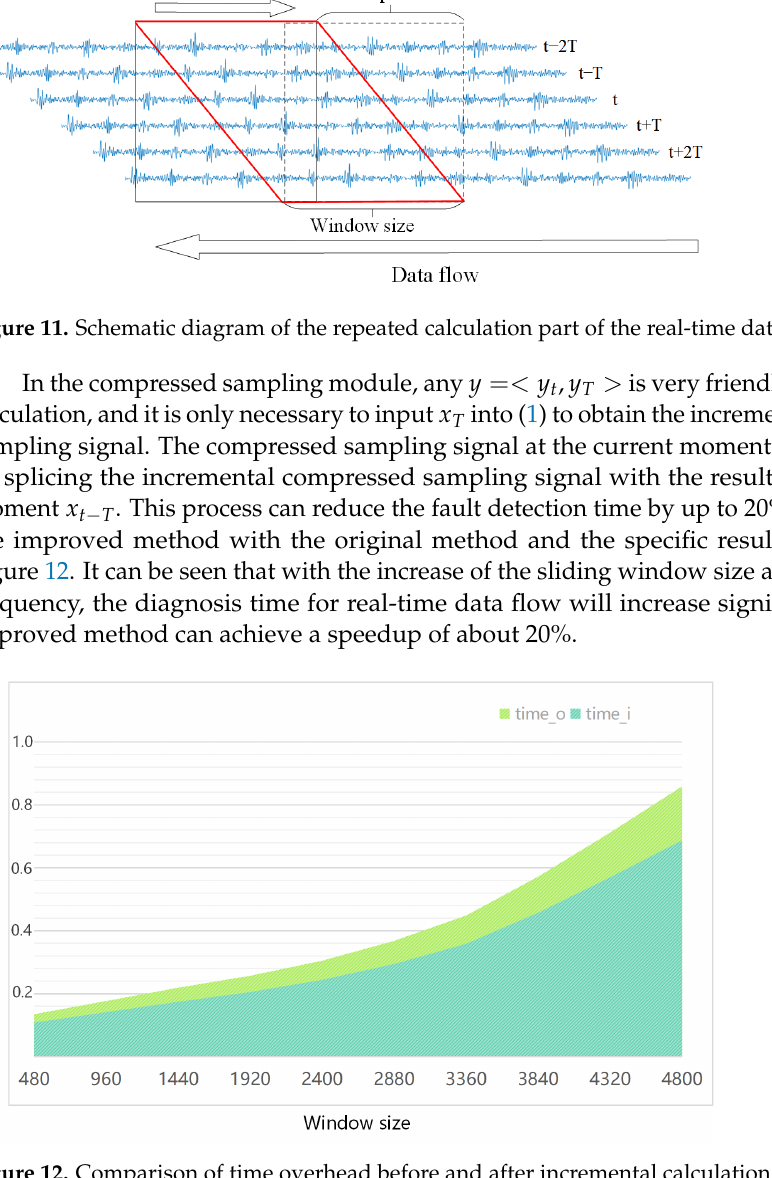
Figure 12. Comparison of time overhead before and after incremental calculation